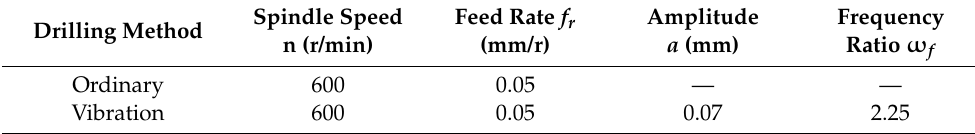
Table 3. Drilling process parameters.